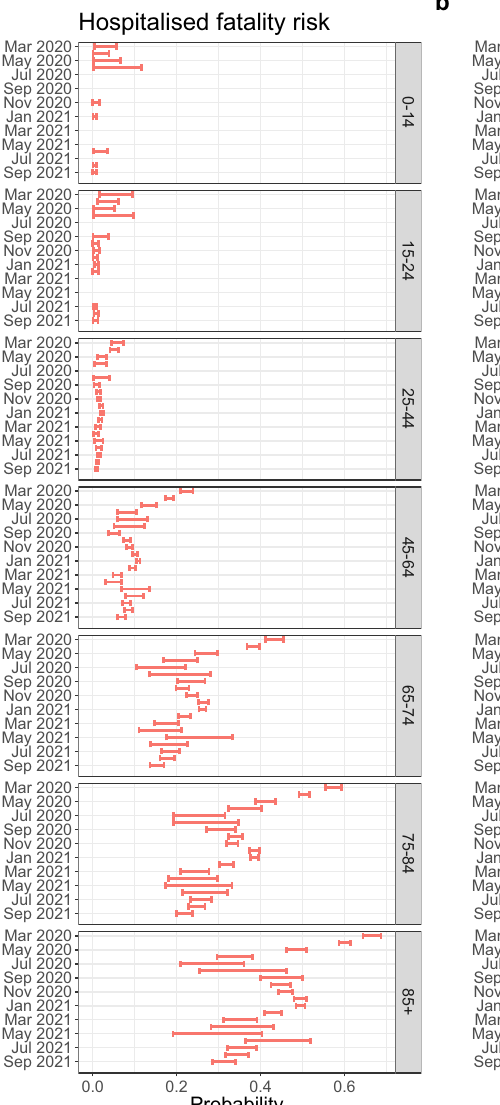
Line ranges indicate 95% confidence intervals around median. Fig.4|Hospitalisedfatalityriskandmedianlengthofstaybymonthofhospital admission and age group. a Hospitalised fatality risk and b median length of stay in hospital prior to death or discharge by month of hospital admission and